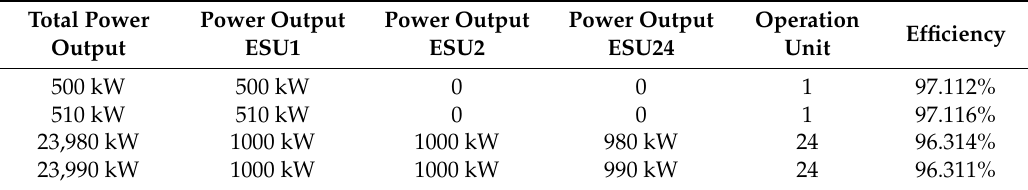
Table 1. The structure of the lookup table for optimal power assignment.